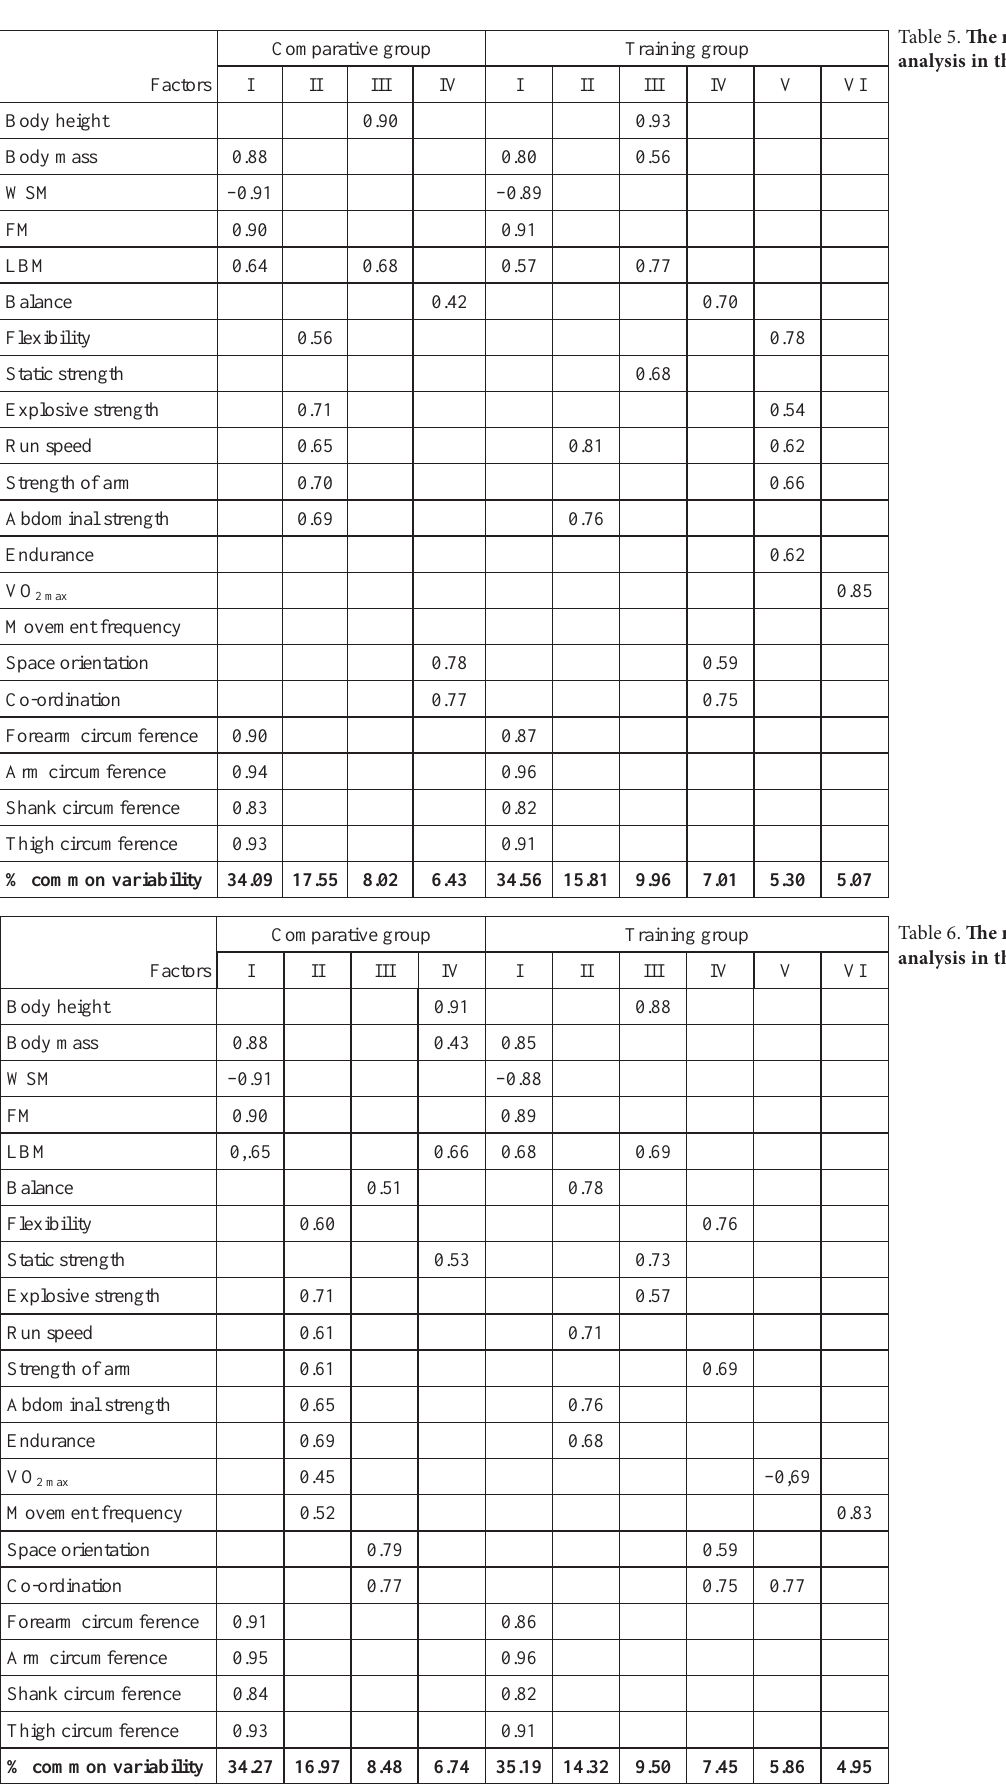
Table 5. Th e results of the factor analysis in the research I